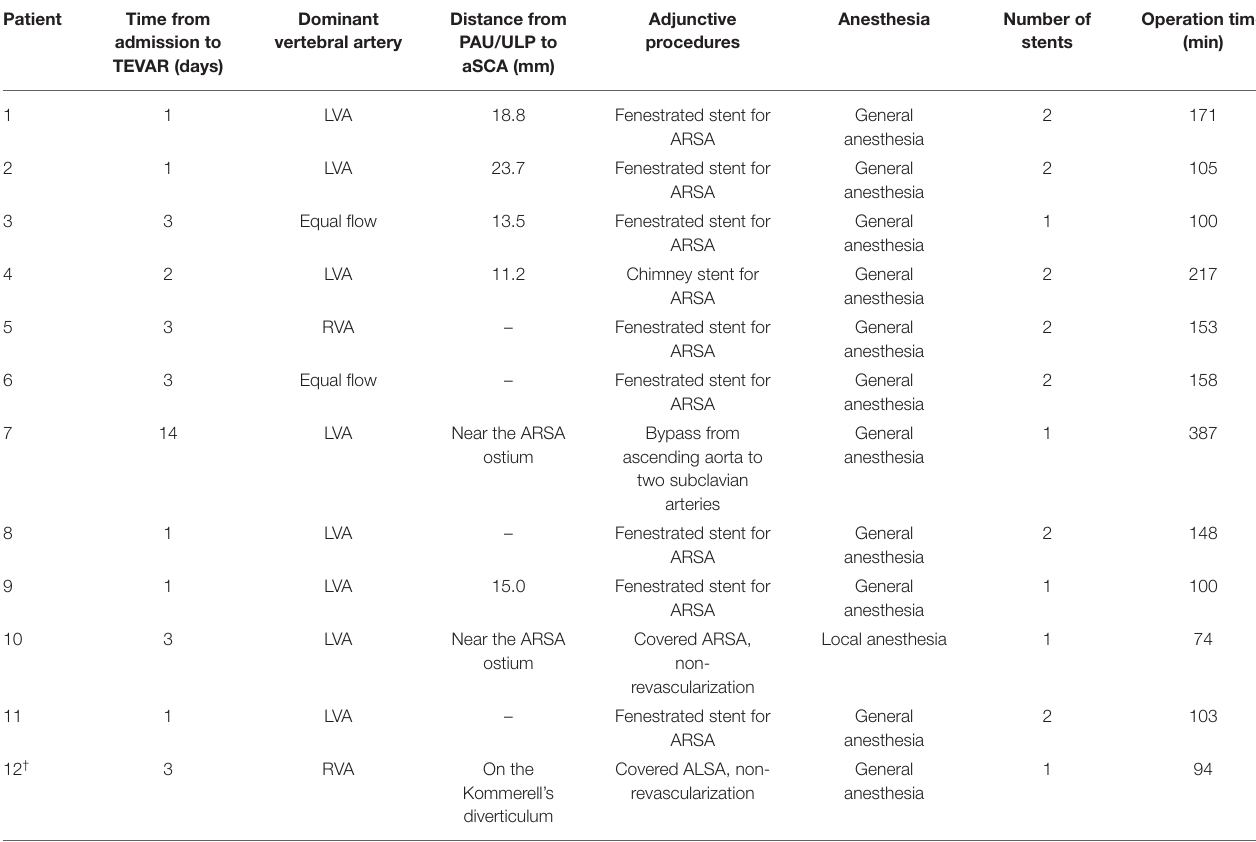
TABLE 3 | Details about thoracic endovascular aortic repair